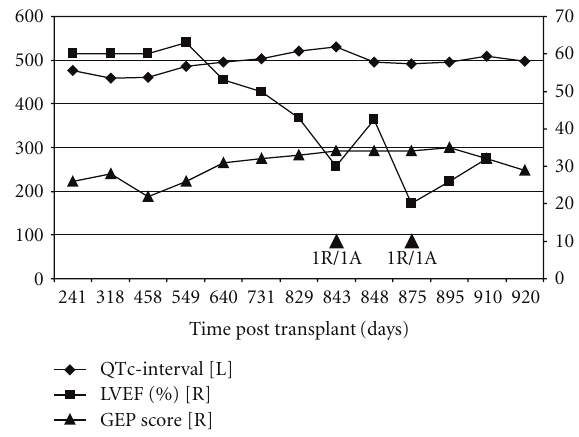
Figure 1: Longitudinal post-HTx changes in the GEP test score, QTc-interval, and Left Ventricular Ejection Fraction. L = left axis; R = right axis; LVEF = left ventricular ejection fraction; GEP = gene expression profiling test score; QTc = corrected QT